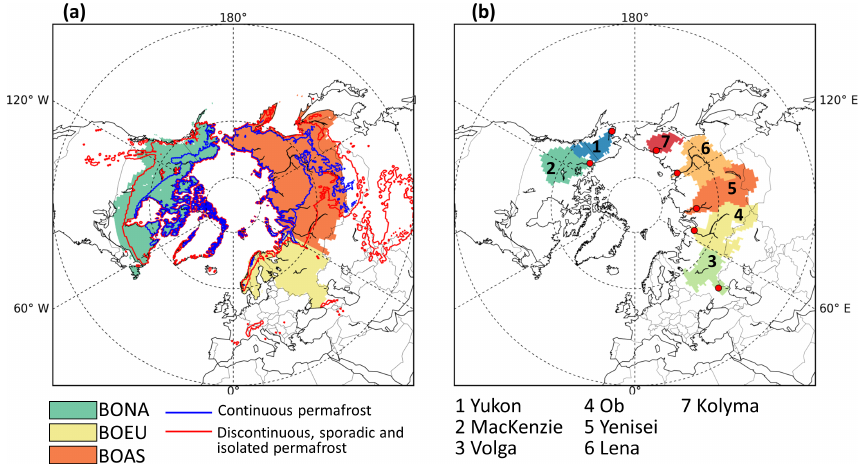
Figure 2. (a) The three high-latitude sub-regions used in this study, including boreal North America (BONA), boreal Europe (BOEU) and boreal Asia (BOAS), following McGuire et al. (2016). Blue and red lines indicate the extent of continuous permafrost and all permafrost categories, respectively, according to the IPA permafrost map (Brown et al., 2002). (b) The seven high-latitude basins selected for this study with the gauge stations (red circles on the map, more information in Table